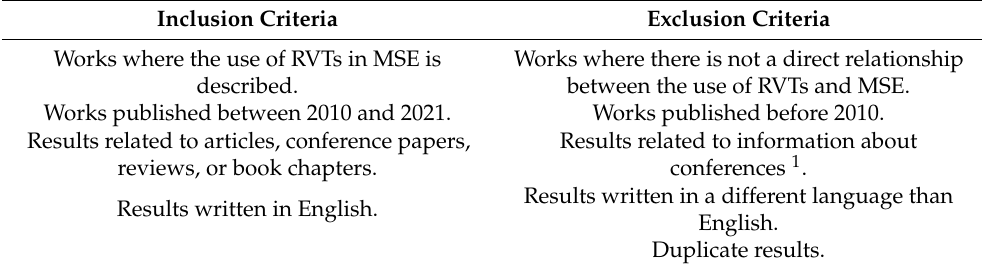
Table 2. Inclusion and exclusion criteria that were followed to select relevant